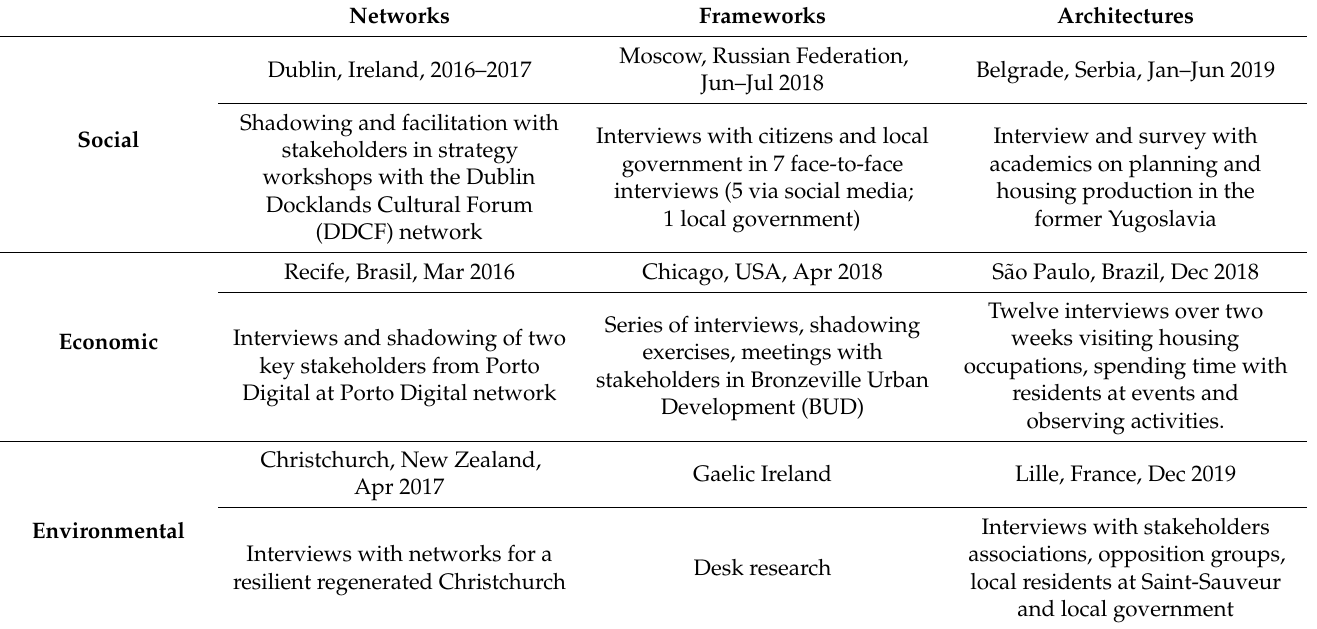
Table 2. Research methods used in case